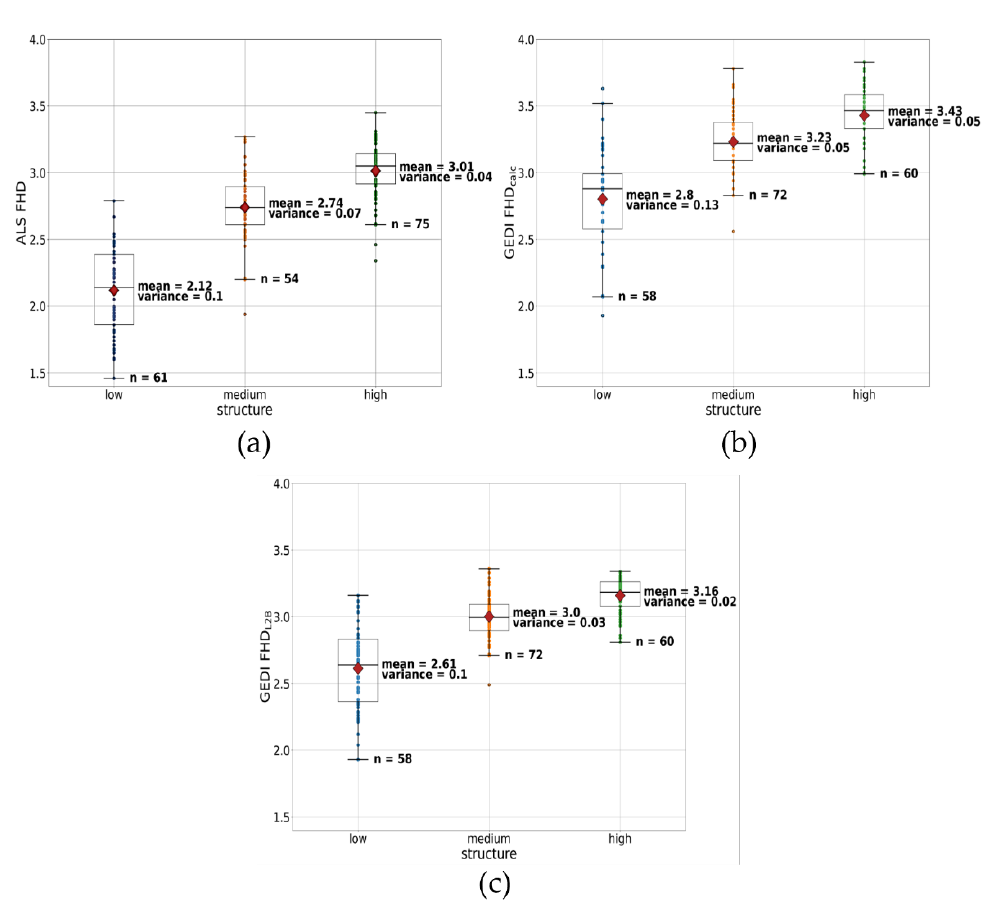
Figure 7. ( a ) ALS FHD, ( b ) GEDI FHD calc and ( c ) GEDI FHD L2B each vs. interpreted vertical structure (low, medium and